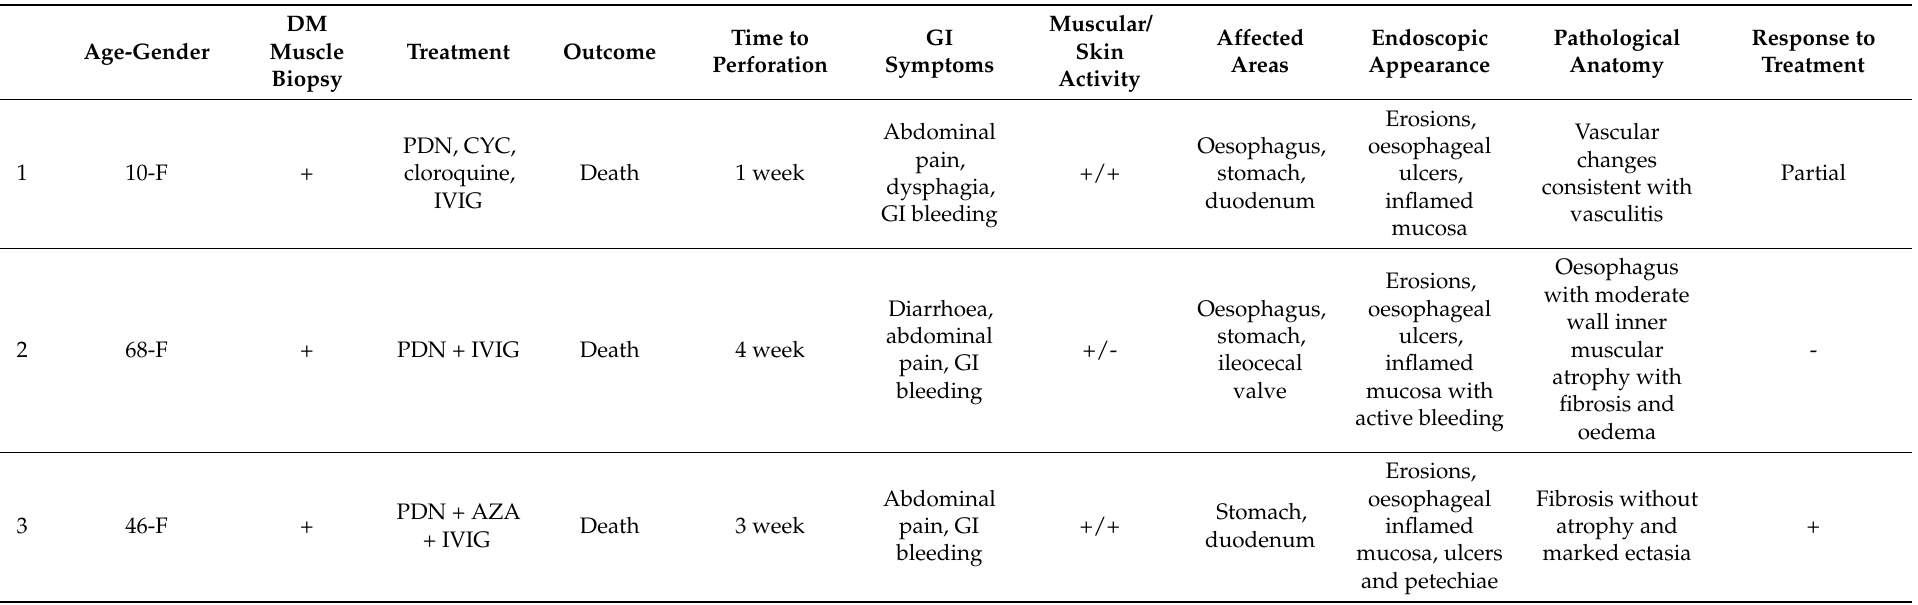
Table 1. Characteristics of patients with DM and severe GI compromise from our unit at the Hospital Cl í nic de